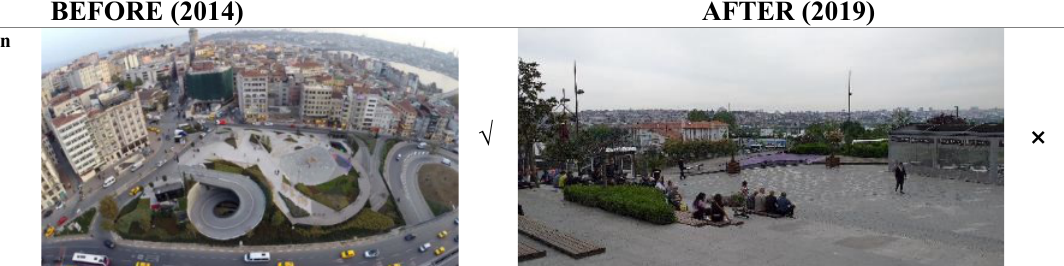
Table 6. Analysis of "Şışhane Park" according to derived aesthetic standards; (Improved by author); figures source (B efore: URL8, after: by